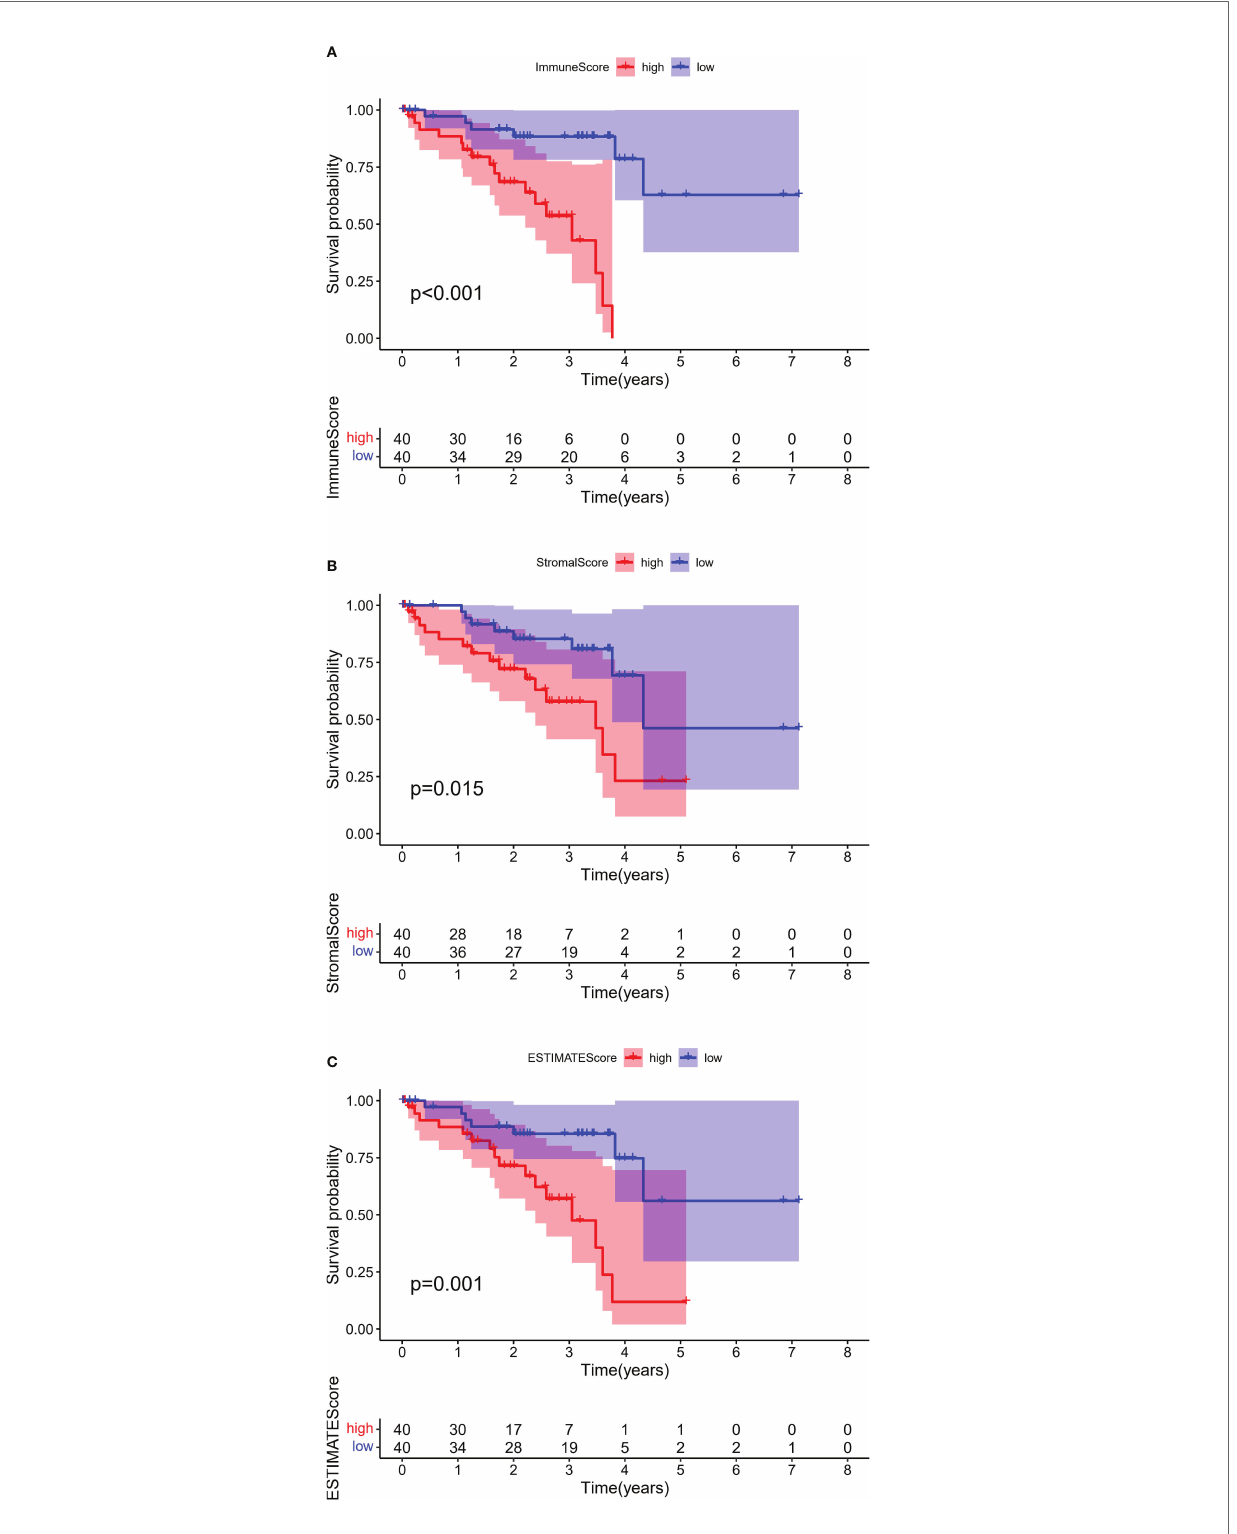
FIGURE 2 | Kaplan – Meier survival analyses of overall survival in UM with high (red line) and low (blue line). (A) Immune scores, (B) Stromal scores, and (C) ESTIMATE scores. The numbers shown below the survival curves are the number of patients at risk at the speci fi ed year. The shaded red or blue represent 95% con fi dence